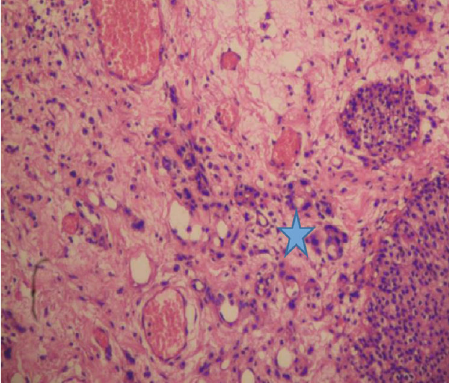
Figure 3: In fi ltration of the subepithelium of the bladder with a small aggregates of neoplastic cells (H&E, × 200).